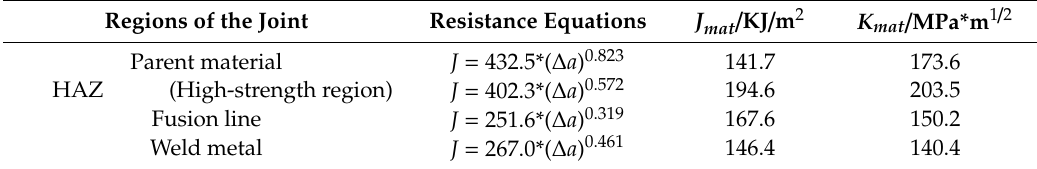
Table 10. The resistance equations and the J mat and K mat values of the undermatched welded joint after the crack amendment based on the XFEM.